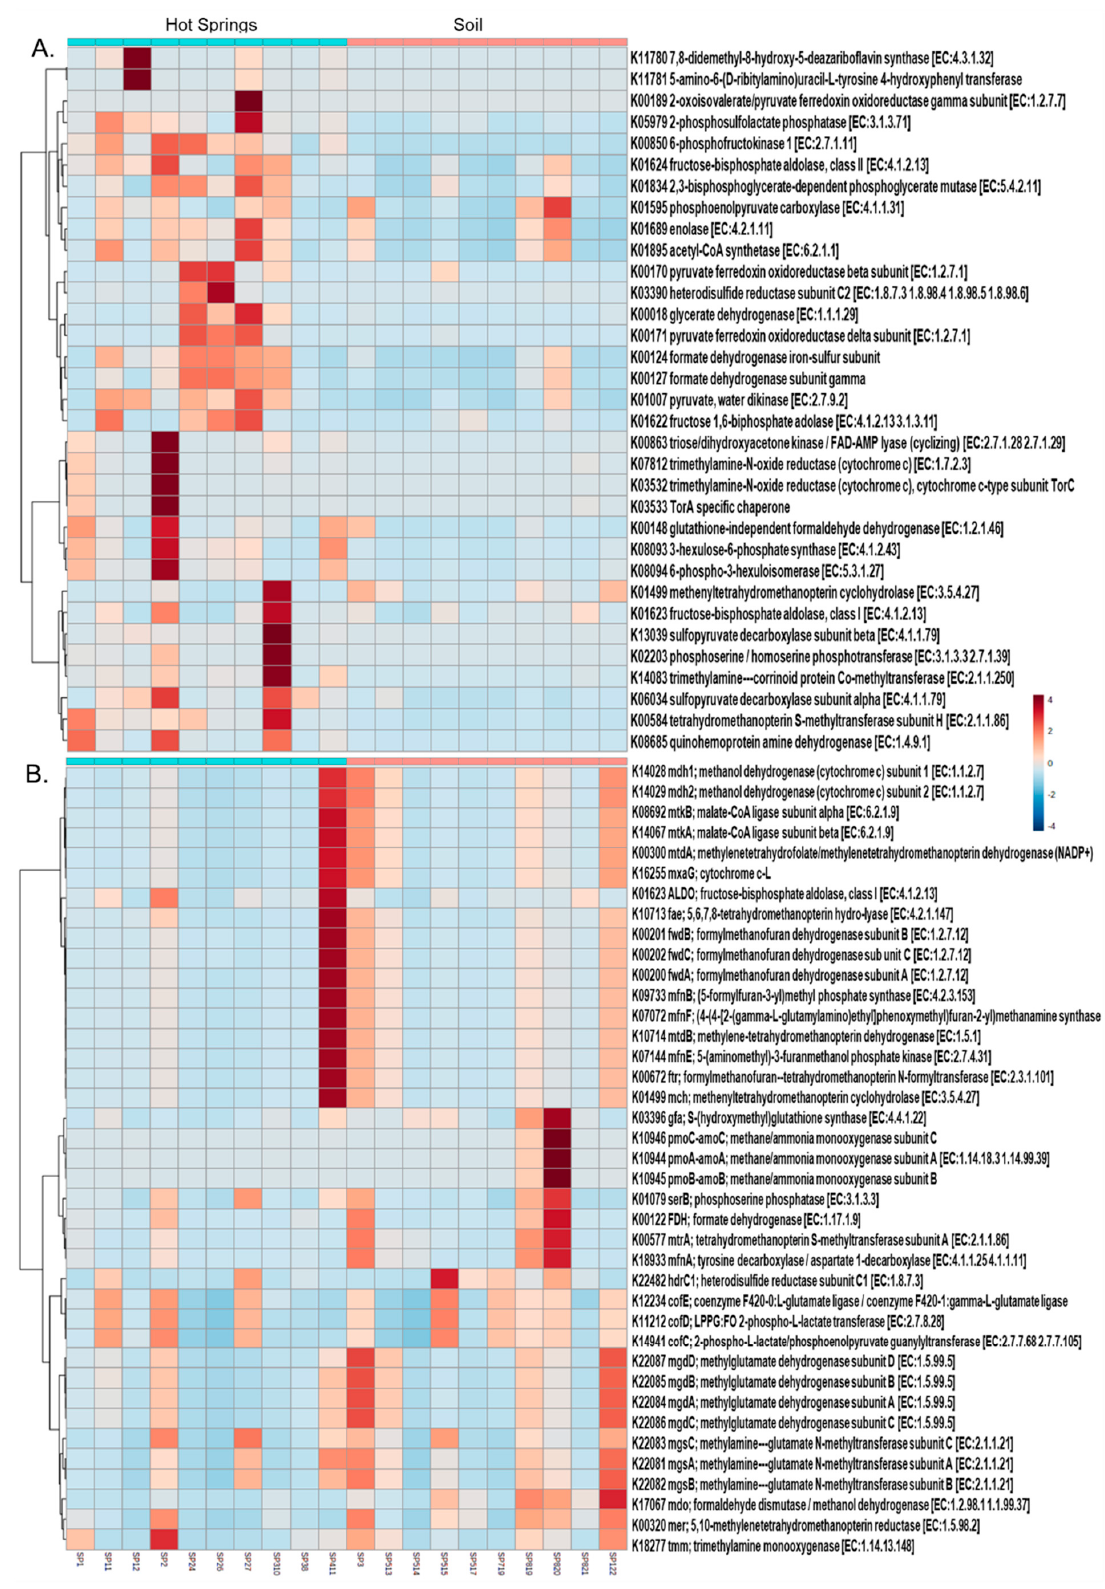
Figure 6. Differentially abundant genes involved in methane metabolism. The hot spring microbiome ( A ) was found to be abundant in the genes involved in the anaerobic methane degradation as compared to the aerobic methane degradation in the soil microbiome ( B